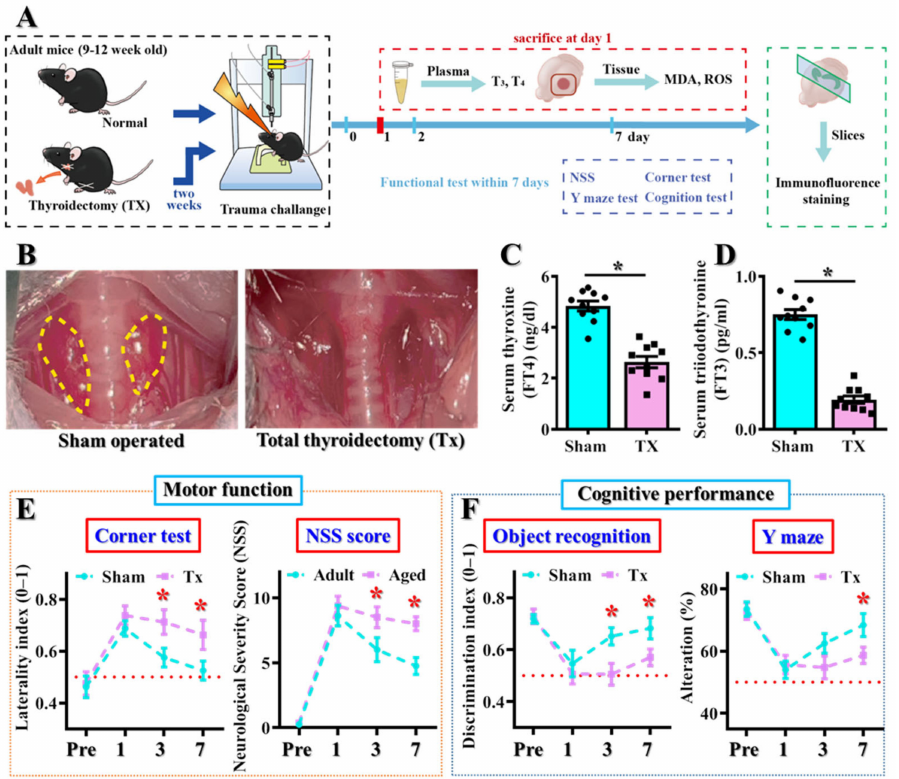
Figure 4. Increase in TBI-susceptible phenotypes after surgical thyroidectomy. ( A ) Schematic illustration of the experimental designs; ( B ) Representative images showing the surgical removal of bilateral thyroid lobes. ( C , D ) Quantification of the serum free T4 and free T3 levels. n = 8 to 10 mice. Data are presented as mean ± SEM and are analyzed by a two-tailed unpaired t -test. * p < 0.05. ( E ) Behavioral performance of motor function, including corner test and neurological severity scores at different time points after CCI challenge; ( F ) Behavioral performance of cognitive function in the object location recognition task and spontaneous alternation Y maze at different time points after CCI. n = 8 to 10 mice. Data are presented as mean ± SEM and are analyzed by a one-way repeated measures ANOVA with Bonferroni’s post hoc analysis. * p <